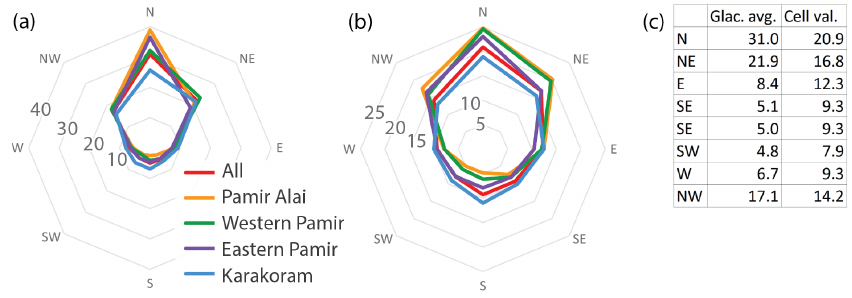
Figure 8. Glacier orientation of the different HMA regions. (a) shows the values based on average glacier aspect; (b) is based on the 30m raster cells. Lower elevations tend to have a higher share of the north-facing glacier area. The respective numbers of “All” are given in the table (c) .